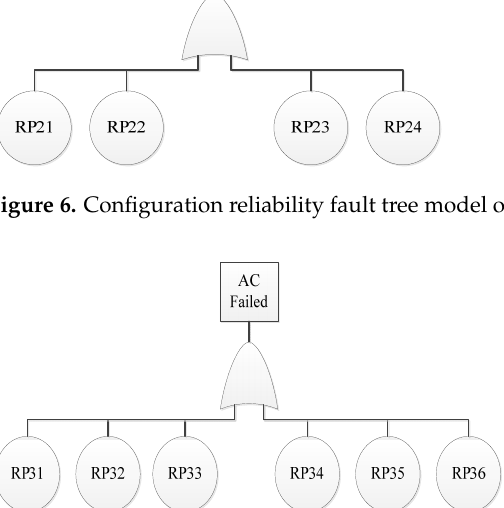
Figure 7. Configuration reliability fault tree model of the AC phase.